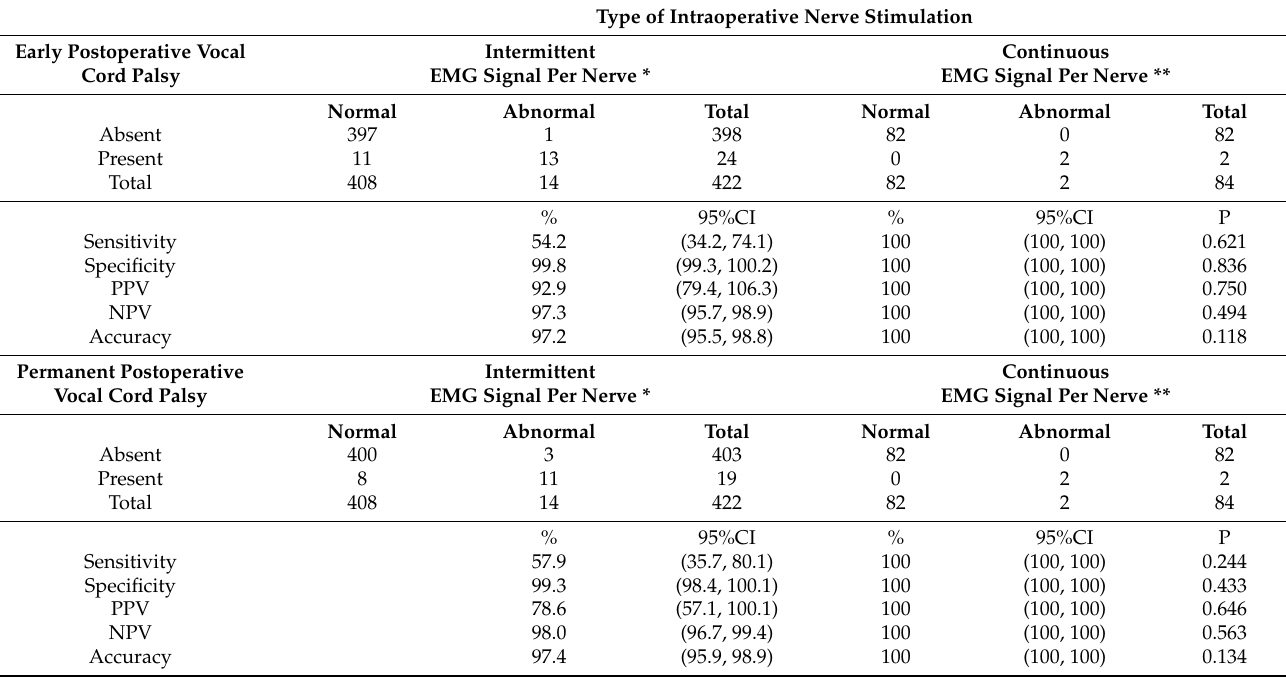
Table 5. Prediction of early and permanent postoperative vocal cord palsy by type of intraoperative nerve stimulation.